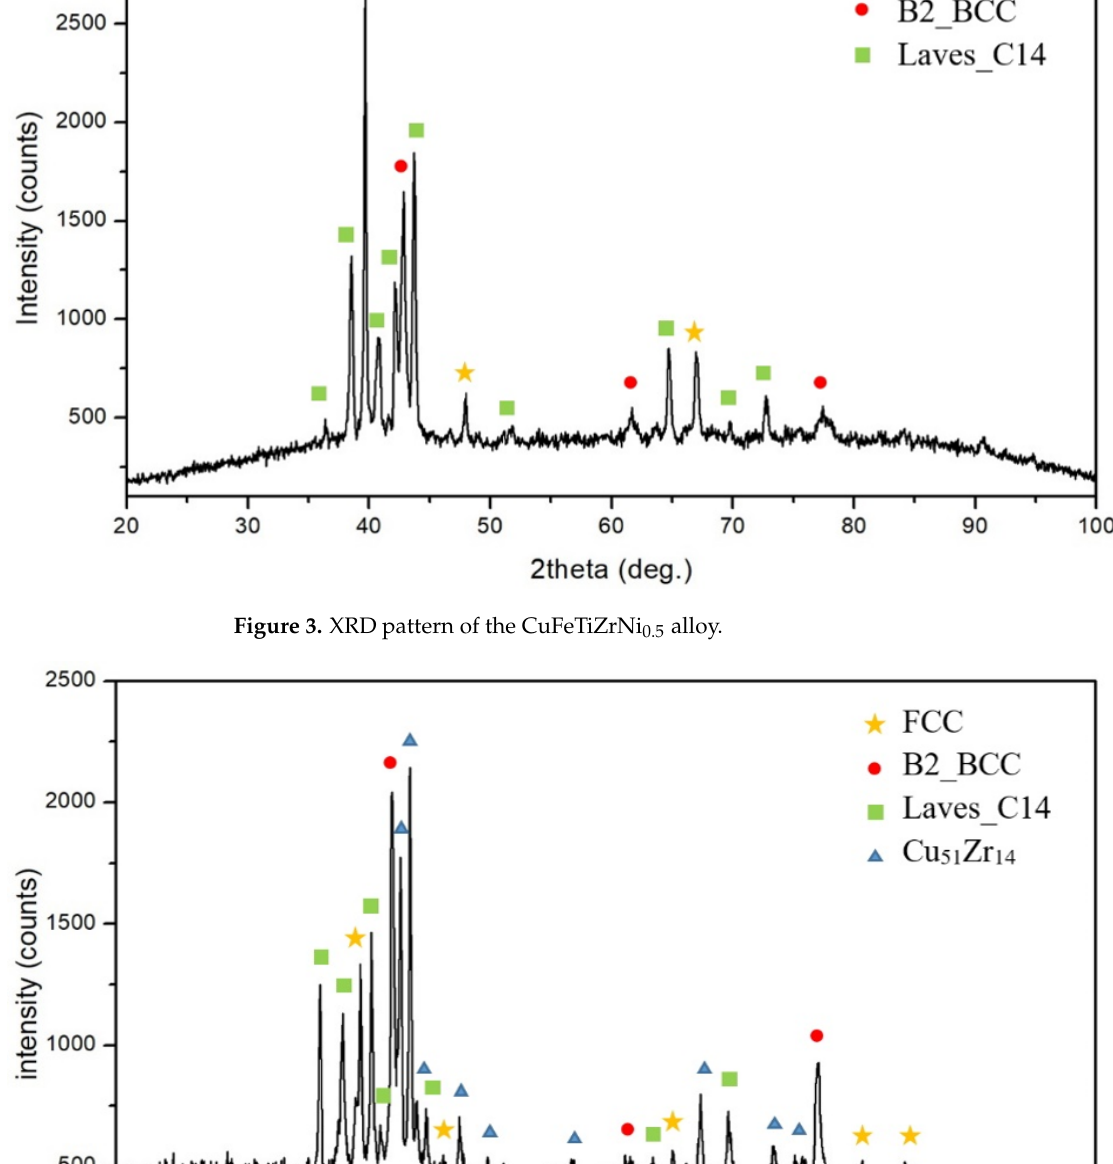
Figure 4. XRD pattern of the CuFeTiZrNi 1.0